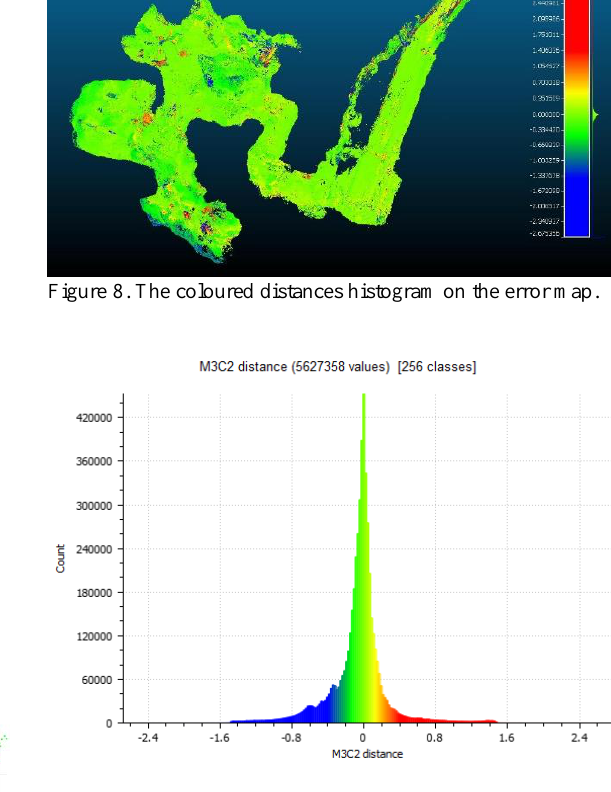
Figure 9. The histogram of the M3C2 distances between the registered